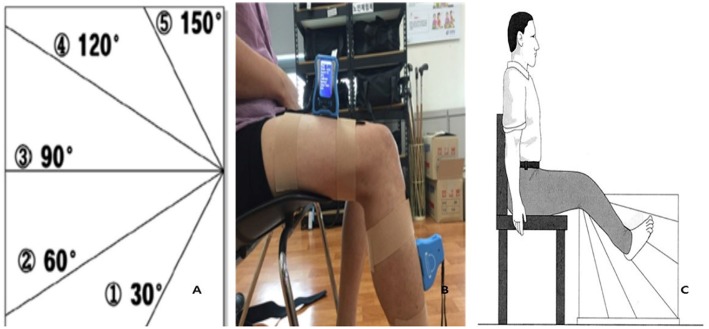
Proprioception test (A: Acryl panel, B: Electrogoniometer, C: Test position). Reproduced with permission from Lord et al. (22).